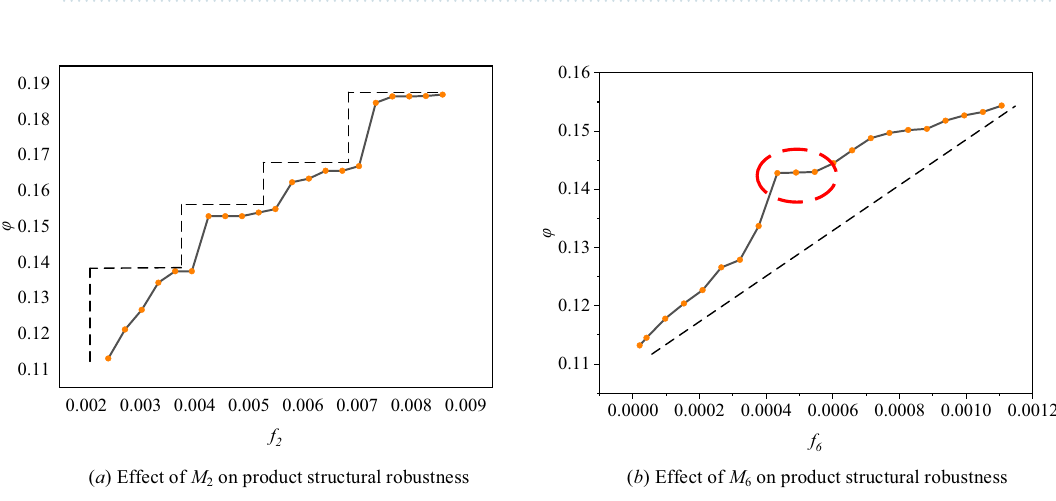
Figure 11. A four-node loop structure was added to keep the camera stable. (Adapted in part with free permission from iFixit, https:// www. ifixit. com/ Teard own/ iPhone/. Licenced under the CC BY open access licence).